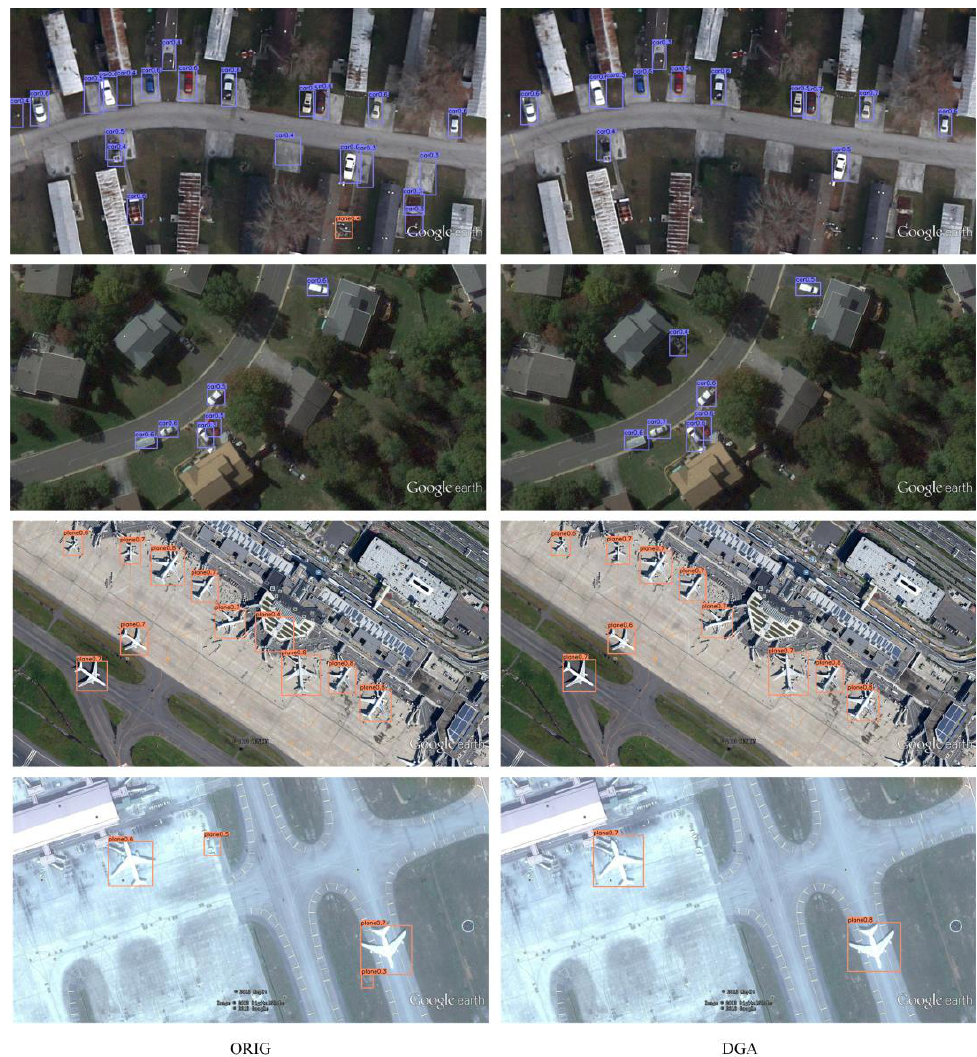
Figure 6. Selected detection results of the original network and the DGA network. The first column shows the results of the original network, while the second column shows the results of DGA.